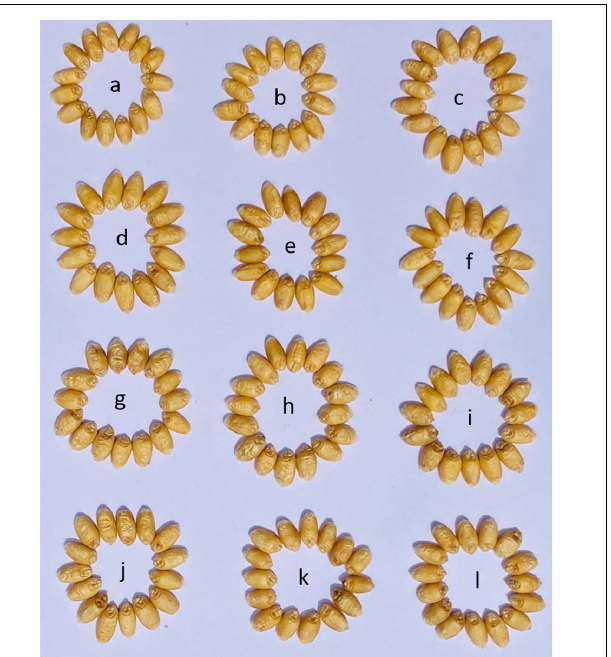
FIGURE 4 | Representative grains from the field grown pyramided lines along with parental genotypes. (a) PBW550. (b) PBW550 + Yr15 . (c) PBW550 + Yr15 + Lr57-Yr40. (d–f) BC 2 F 5 progenies obtained from cross of HGW343 × PBW550. (g–i) F 4 progenies obtained from cross of